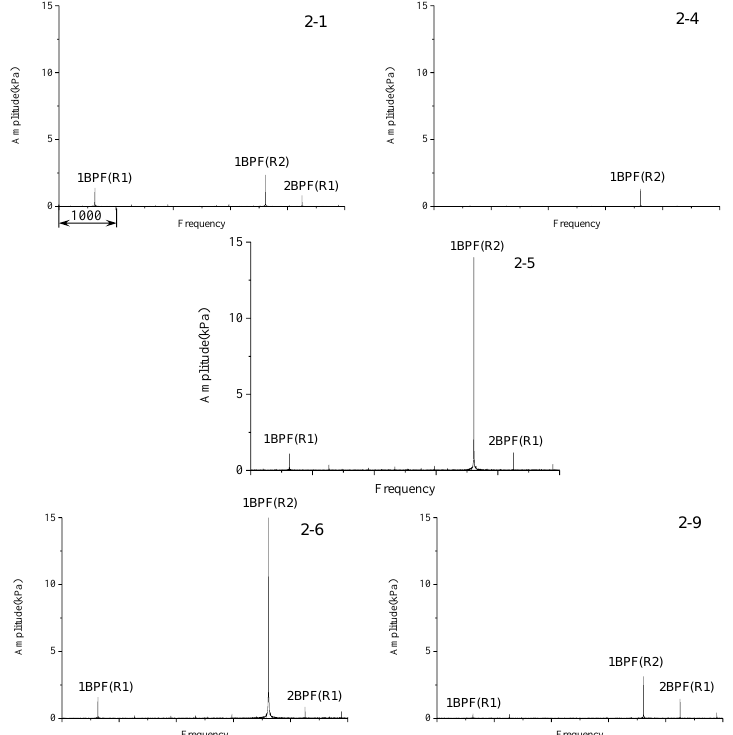
Figure 23. Changes in the pressure frequency spectrum inside R2; near choke condition .